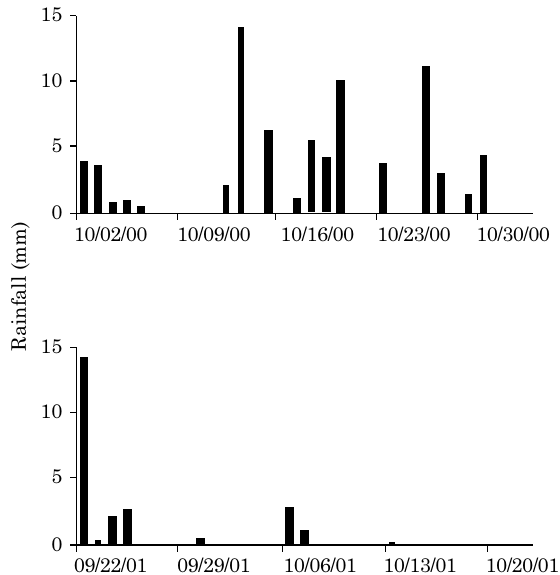
Figure 1. Daily rainfall events in the 30 days before sampling in the dry season of 2000 (on November 2, 2000) (a) and of 2001 (on October 2, 2001) (b).